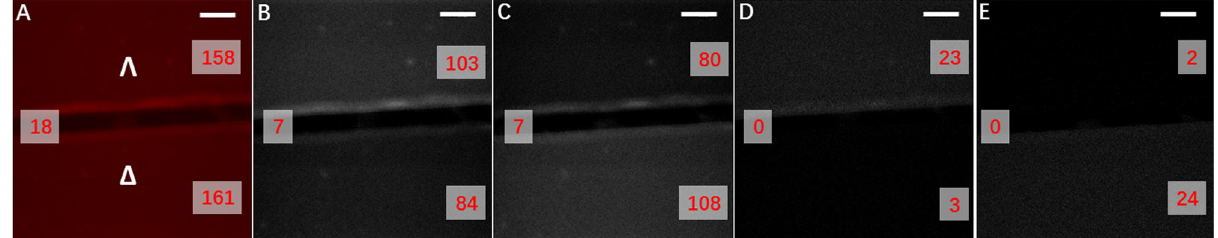
Fig. 4 Enantioselective differential chiral contrast (EDCC) CPL-LSCM of Λ - and Δ -Eu:L1 on a glass substrate. A Total europium emission ( λ ex = 355 nm, 20 mW, λ em = 589 to 720 nm). B , C Left and Right Handed CPL channel respectively ( λ em = 589 to 599 nm). D Left-handed EDCC image (left CPL — right CPL). E Right-handed EDCC image (right CPL — left CPL). The objective used: ×40 0.7 NA air, 210 × 210 µ m FOV, 100 avg, 1.5 µ m axial section. Scale bars = 30 µ m, numbers in red are avg. Eight-bit pixel intensity values for each image